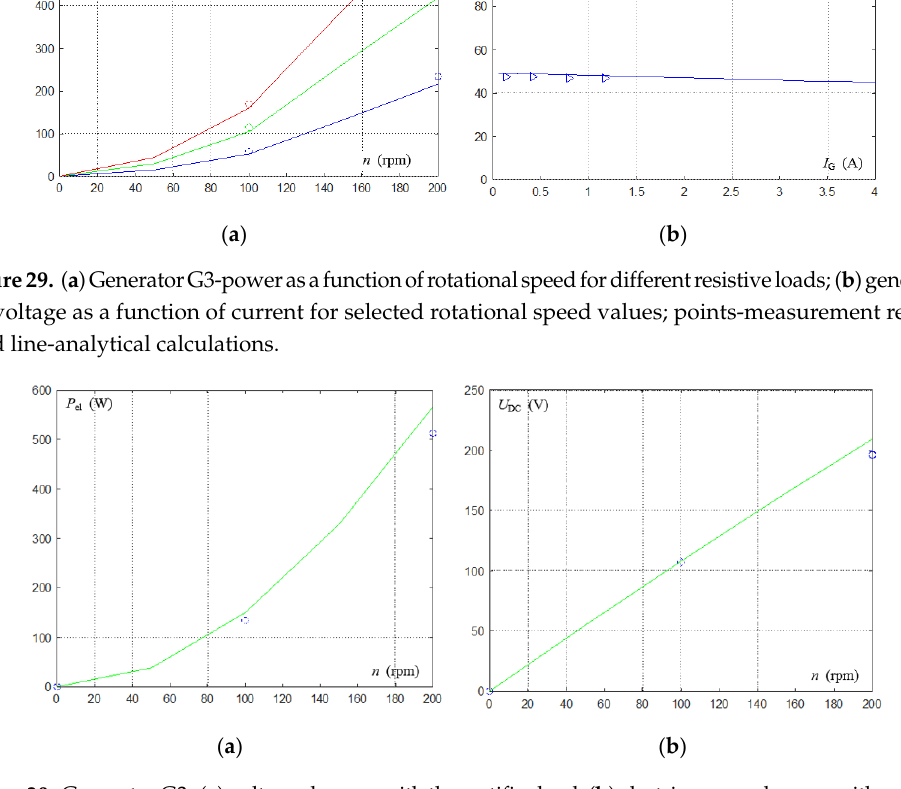
Figure 30. Generator G3: ( a ) voltage changes with the rectifier load; ( b ) electric power changes with rectifier load; for selected rotational values, points-measurement results, solid line-analytical calculations.